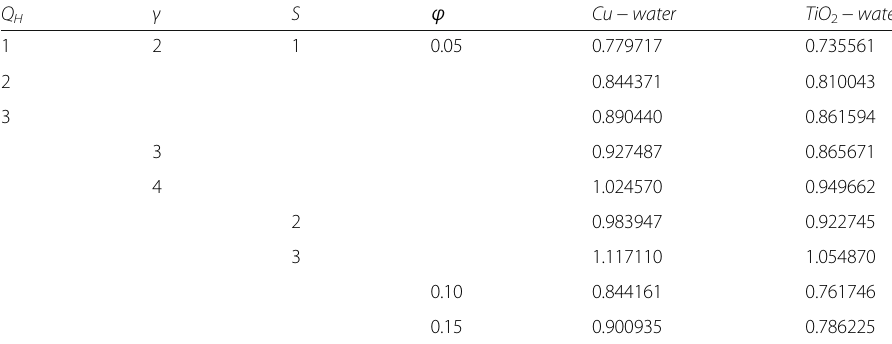
Table 3 Local Nusselt number ( Nu /Re x )